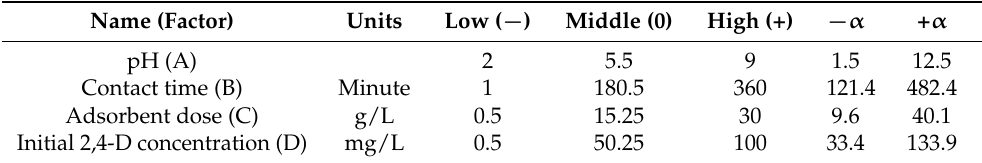
Table 1. Factors and levels designed to remove 2,4-D in percentage.